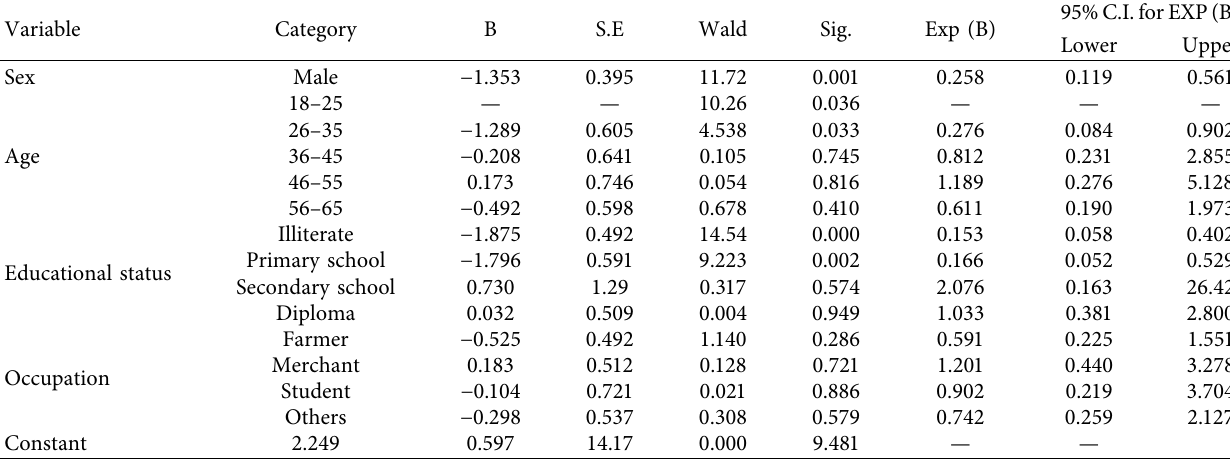
Table 8: Multivariable binary logistic regression analysis of attitude able factors for the elimination of onchocerciasis from Gesha town, Ethiopia.